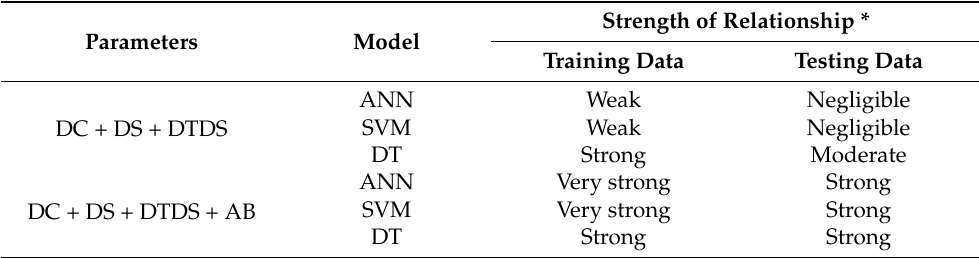
Table 8. Strength of nonlinear relationship for brine and oil/brine parameters.